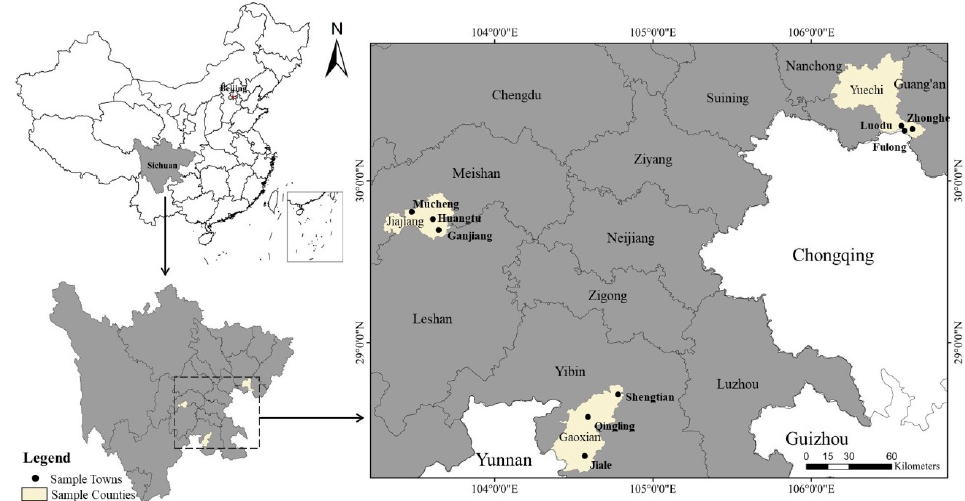
Figure 2. Distribution of sample villages.